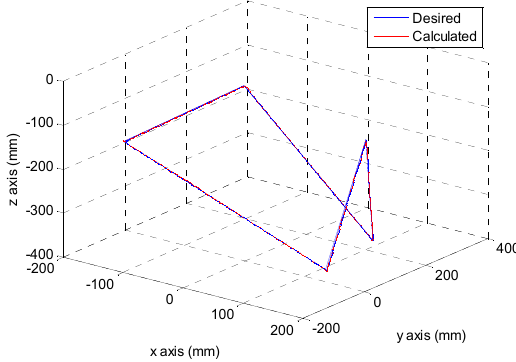
Figure 19. The desired and calculated trajectory.